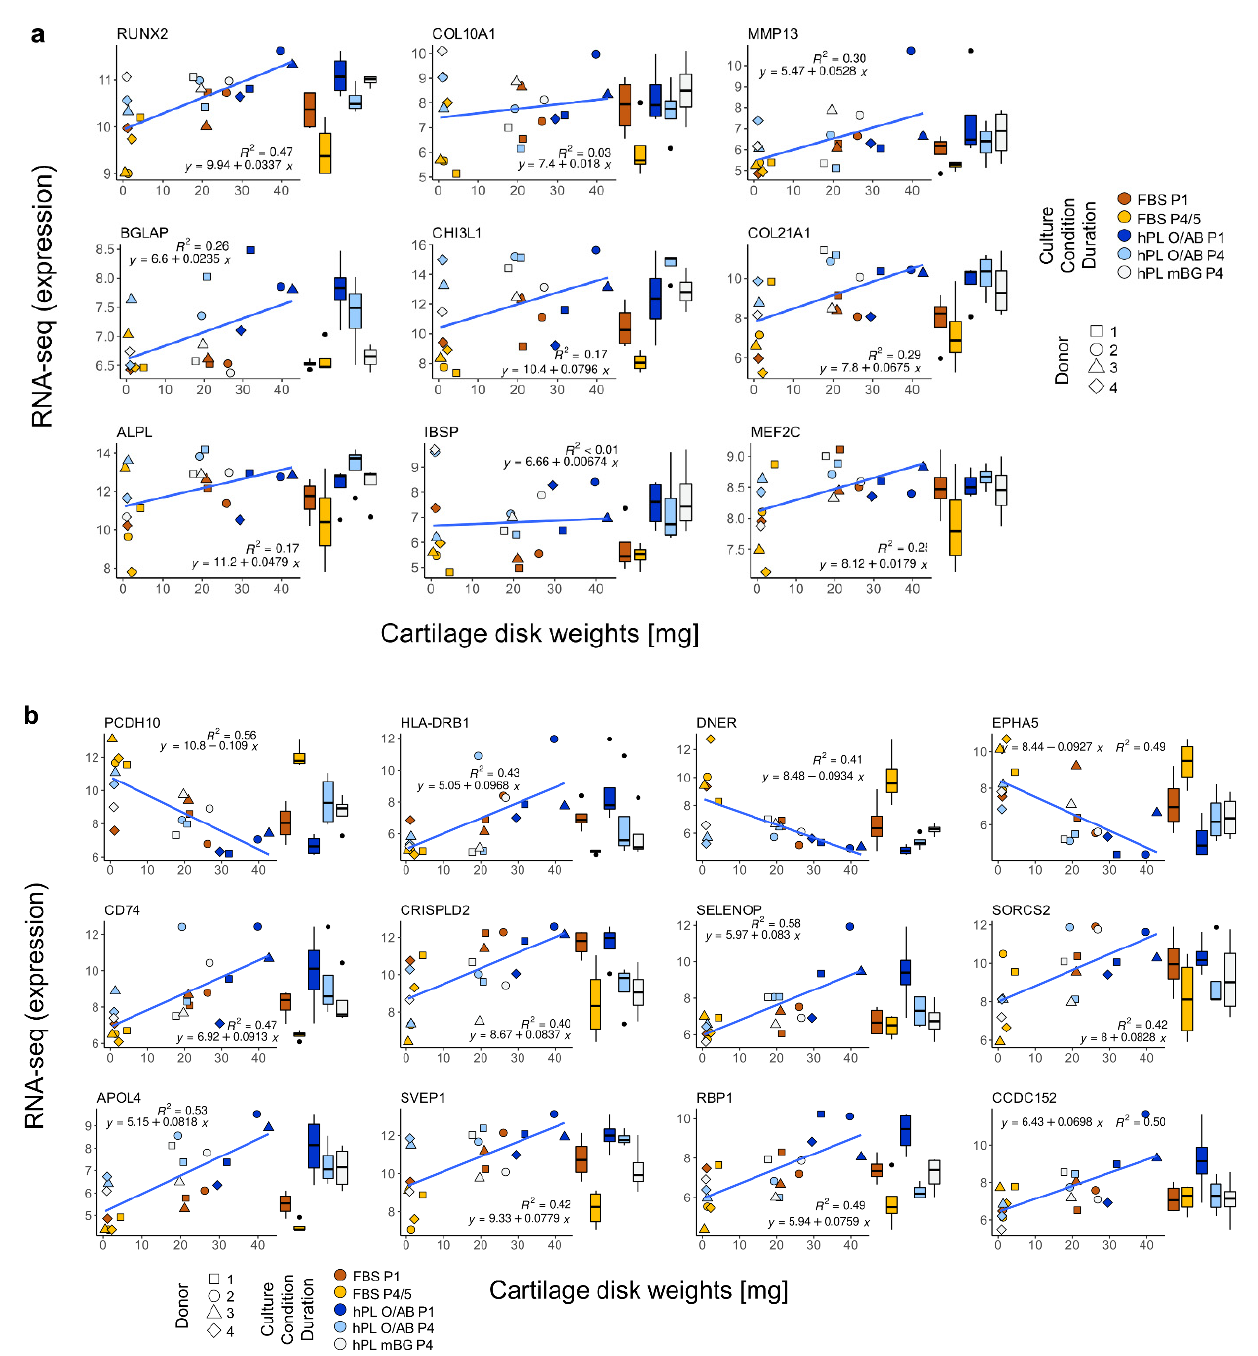
Figure A8. Correlation analysis between RNA-seq gene expression and cartilage disk weight. For each gene, a dual plot shows, on the left side, the correlation analysis between RNA-seq expression on the Y -axis and cartilage disk weights on the X -axis, and on the right side, box plots depicting the RNA-seq signal in the different culture condition. Different donors are depicted by different symbols and culture conditions by different colors, as indicated. A blue linear-regression line is shown together with the regression equation and R2 value. ( a ) Selected genes linked to chondrogenesis. ( b ) Top 12 genes with the highest absolute regression coefficient. Linear regression analysis of differentially transcribed genes was conducted and genes showing significant p < 0.05 and R 2 > 0.40 were selected.